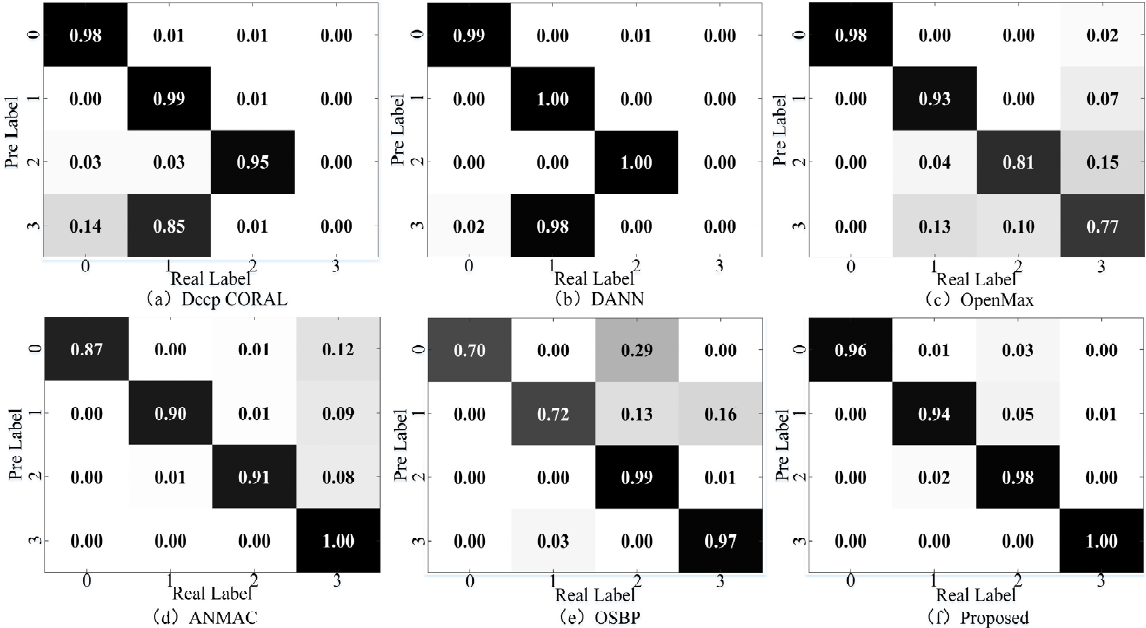
Figure 8. The confusion matrix of the results for transfer task a1. ( a ) Deep CORAL, ( b ) DANN, ( c ) OpenMax, ( d ) ANMAC, ( e ) OSBP, ( f ) Proposed